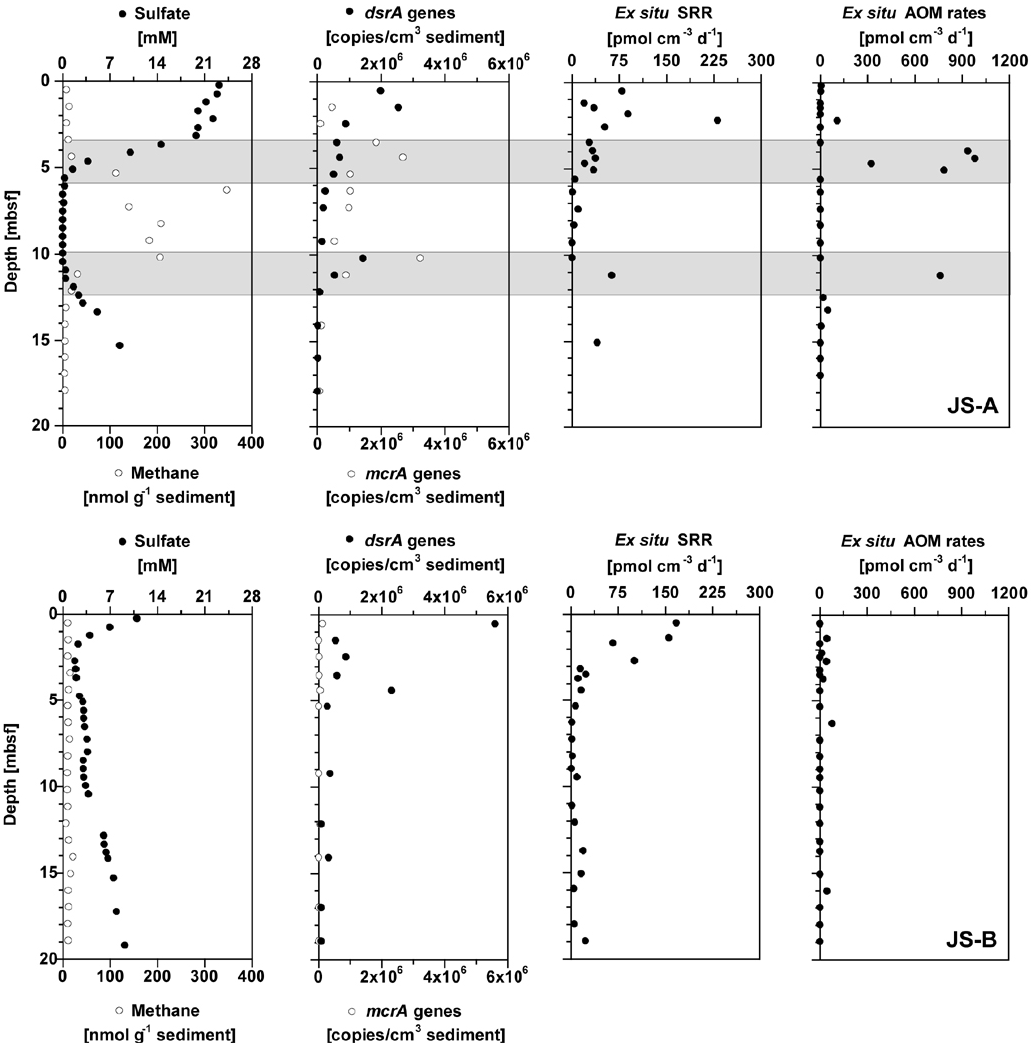
Fig. 6. Sulfate and methane concentrations, copy numbers of dsr A and mcr A genes, ex situ sulfate reduction rates (SRR), and ex situ rates of anaerobic oxidation of methane (AOM) at sites JS-A and JS-B. The grey bars highlight the sulfate-methane interfaces. The same scales are used for both sites. Enhanced ex situ SRR are coupled to higher dsr A copy numbers and consumption of sulfate, whereas a higher abundance of mcr A genes corresponds to methane concentrations. Site JS-A shows two sulfate-methane transition zones with detectable methane consumption and elevated ex situ AOM